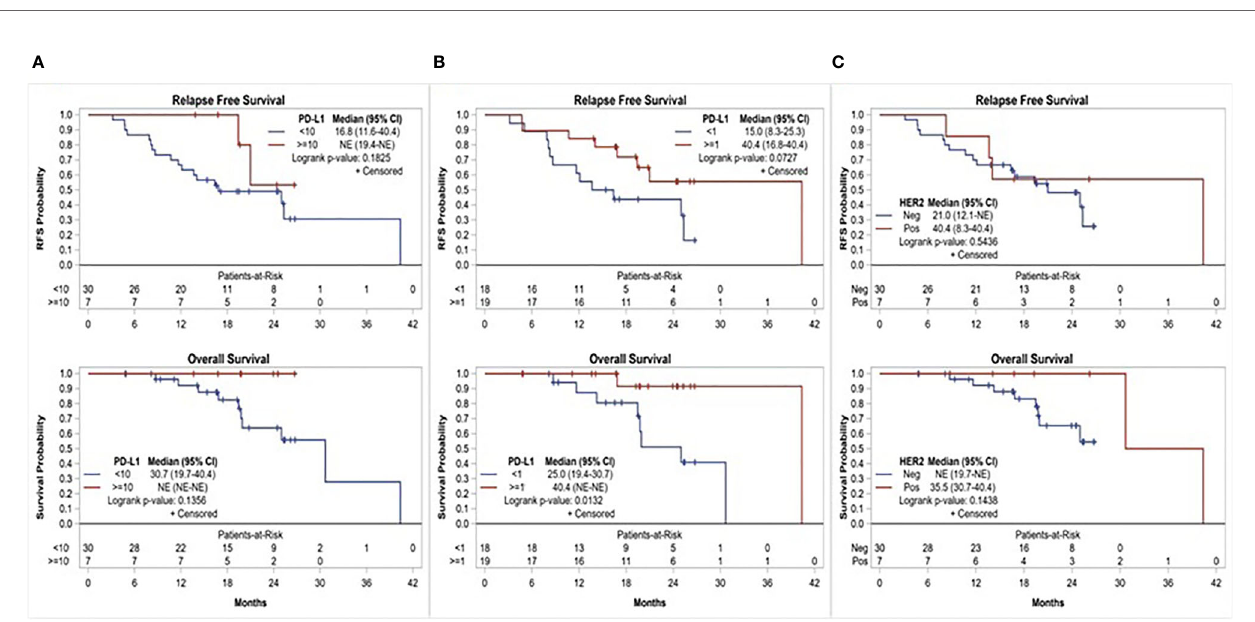
FIGURE 3 | Relapse free survival and overall survival based on, (A) PD-L1 expression using CPS ≥ 10 cutoff, (B) PD-L1 expression using CPS ≥ 1 cutoff, and (C) HER-2 status.